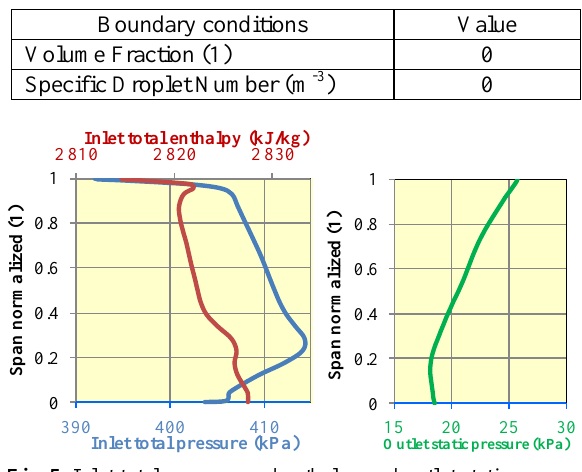
Fig. 5. Inlet total pressure and enthalpy and outlet